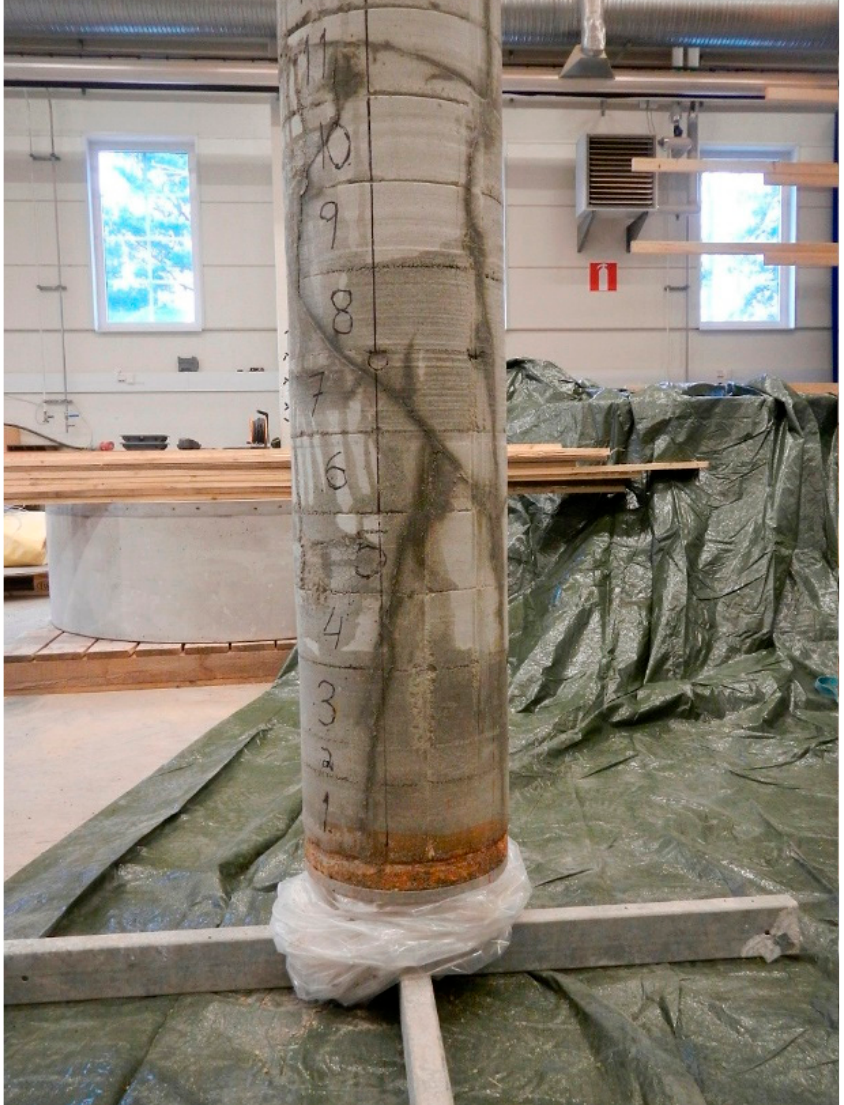
Figure 9. Bentograph showing traces of the flowing fractures on the surface of the retrieved buffer material from a deposition hole.